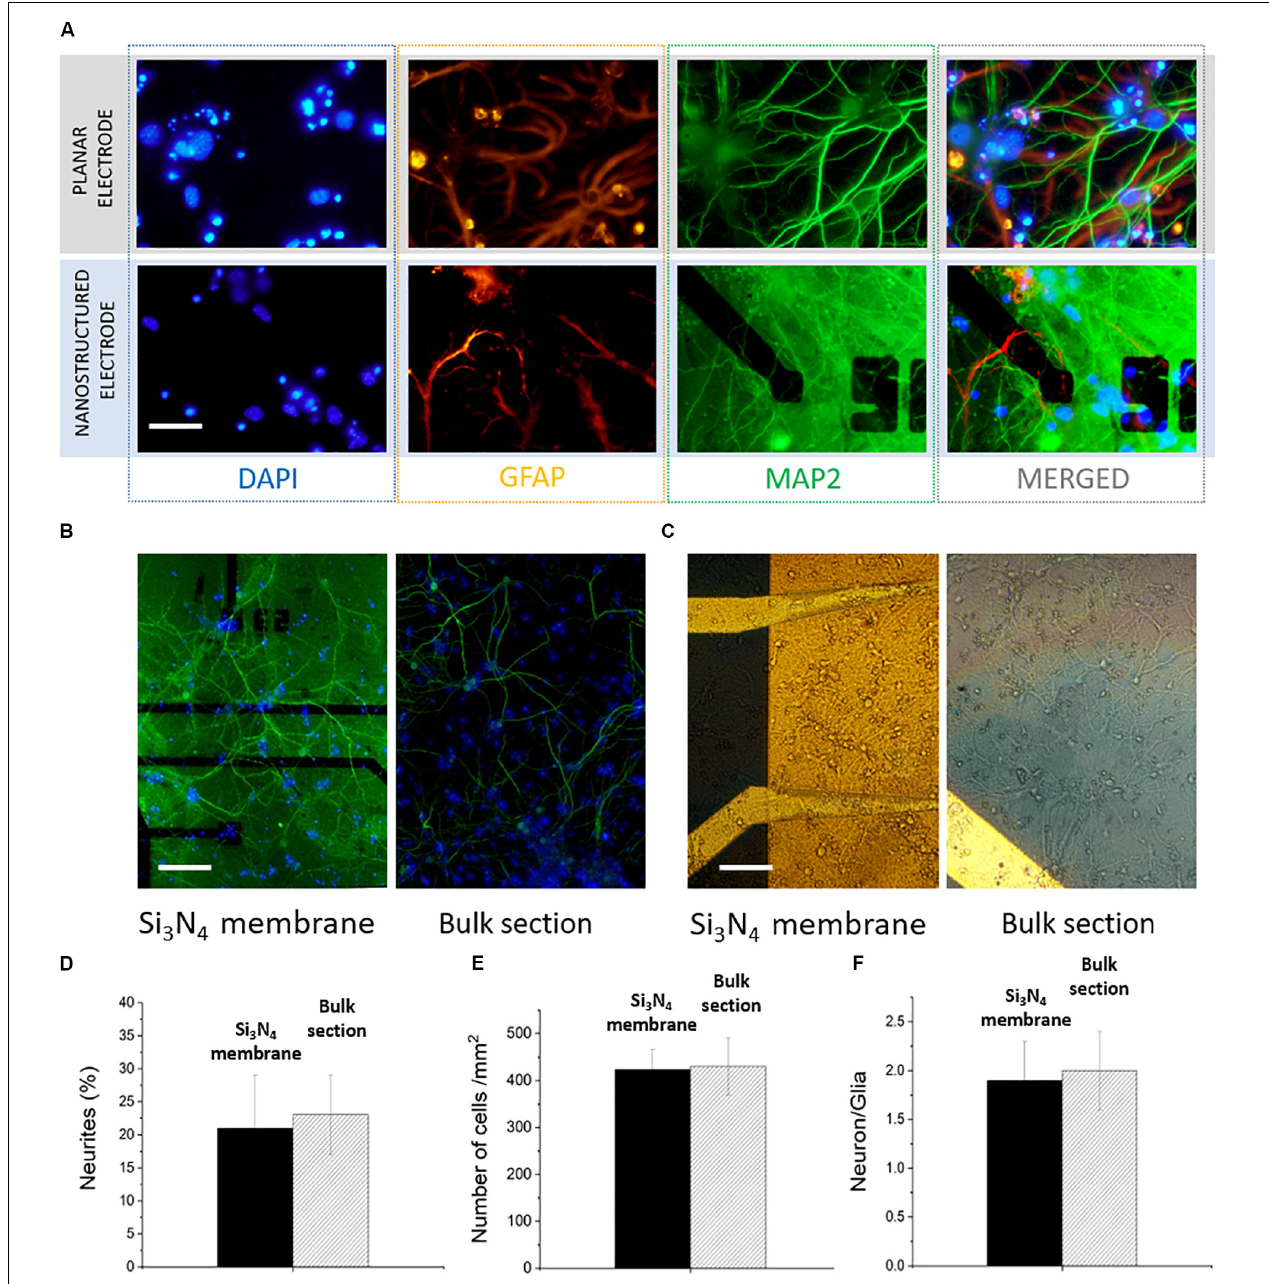
FIGURE 2 | Confocal images of hippocampal neurons of microfluidic MEA. (A) Comparison between a planar electrode on bulk surface and a nanostructured one on thin silicon nitride membrane. Scale bar: 30 µ m. (B) 20x image of the electrodes with microfluidic channel underneath (left) and the bulk surface (right). Scale bar: 100 µ m. (C) 20x bright field images of the network on both surfaces. Scale bar 100 µ m. (D) Percentage of neurites covering the device surface on the of bulk section and on the membrane. (E) Number of cells/mm 2 . (F) Comparison between the calculated neuron/glia ratios on the two sections of the